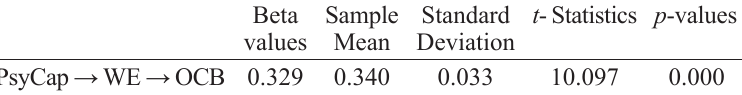
Analysis of the Path Coefficient (Indirect